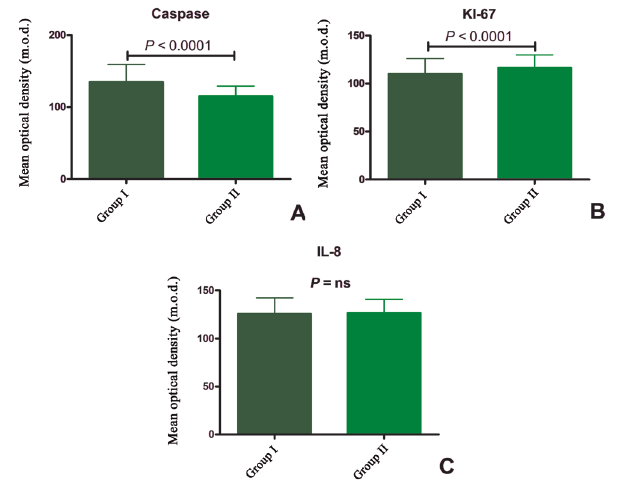
Fig. 1 - Histograms showing mean optical densities of: (A) caspase, (B) KI- 67 and (C) IL-8. Group 1: solution with histidine-tryptophan-ketoglutarate, Group 2: solution with histidine-tryptophan-glutamate